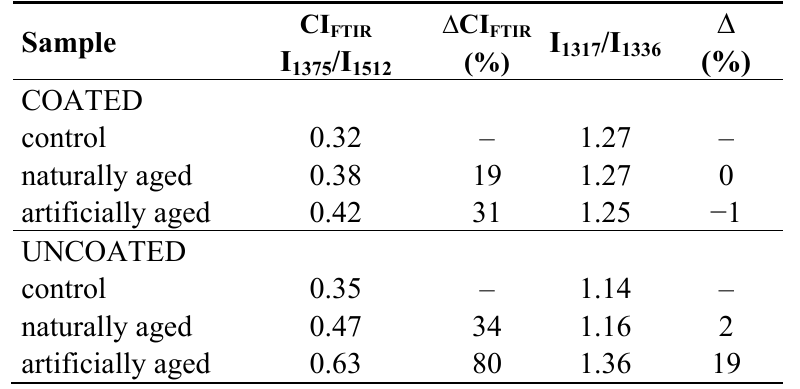
Table 4. Absorbance ratios of wood samples with the indication of percentage variation in properties between aged and control